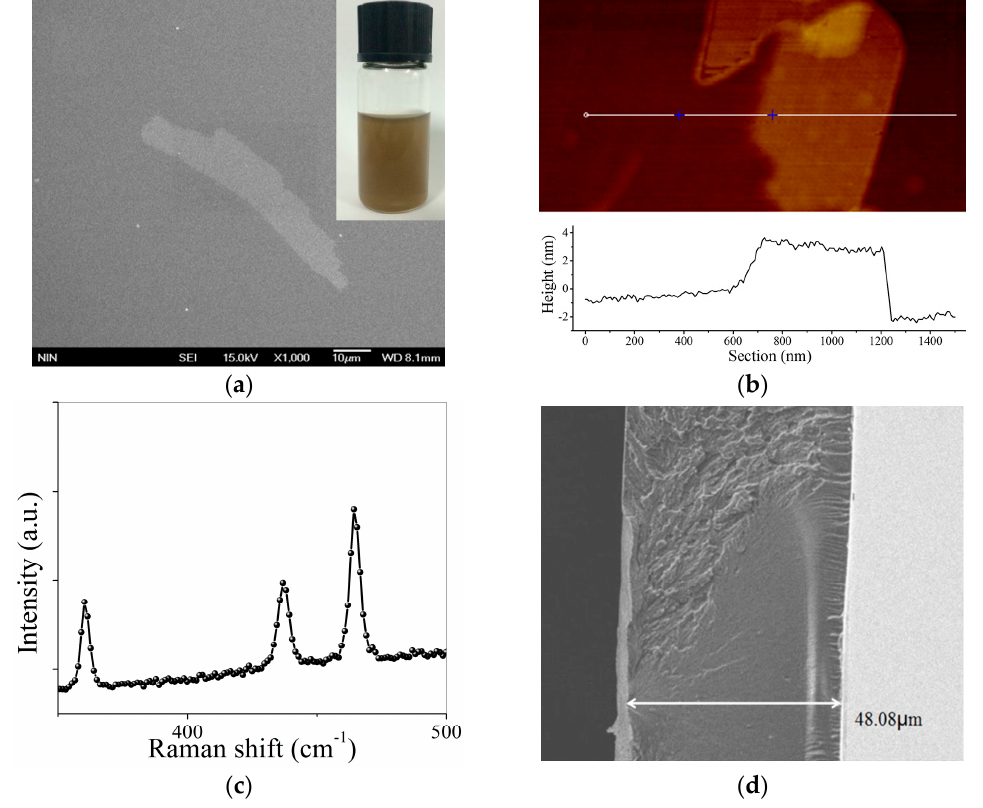
Figure 2. Characterization of BP nanosheets and BP–PI films. ( a ) Scanning electron microscope (SEM) image of the BP nanosheets. The inset is the photograph of the BP nanosheets dispersion; ( b ) atomic force microscopy (AFM) image of the BP nanosheets; ( c ) Raman spectrum of the BP sample; ( d )